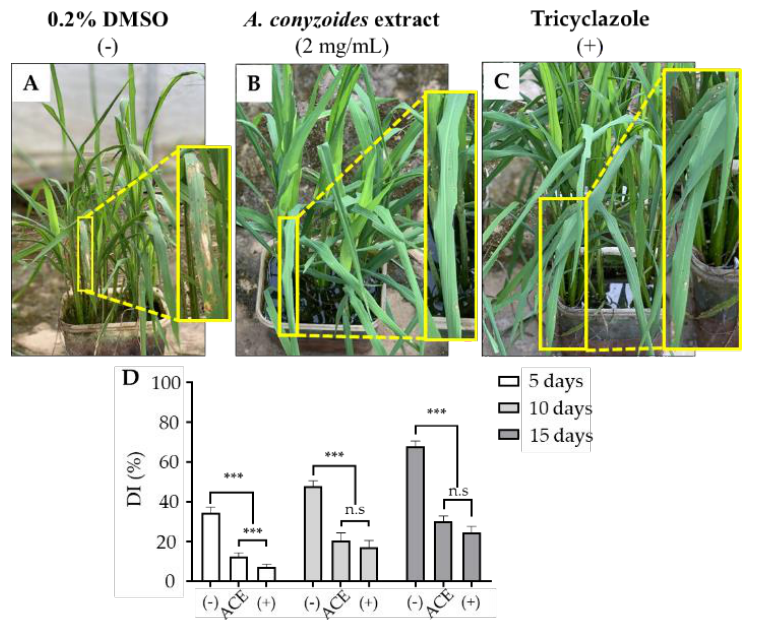
Figure 6. Effects of ACE on blast disease of rice. Rice plants were inoculated with P. oryzae, and subsequently sprayed with 0.2% DMSO ( A ), ACE ( B ), or tricyclazole ( C ). Images are representatives of rice after 15 days’ treatment and include higher magnifications of the boxed regions shown in the left panels ( A – C ). Disease levels were expressed as DI (%) at 5, 10, and 15 days after treatments ( D ). ACE, ACE-treatment; –, 0.2% DMSO treatment (negative control); +, tricyclazole treatment (positive control); ***, p <